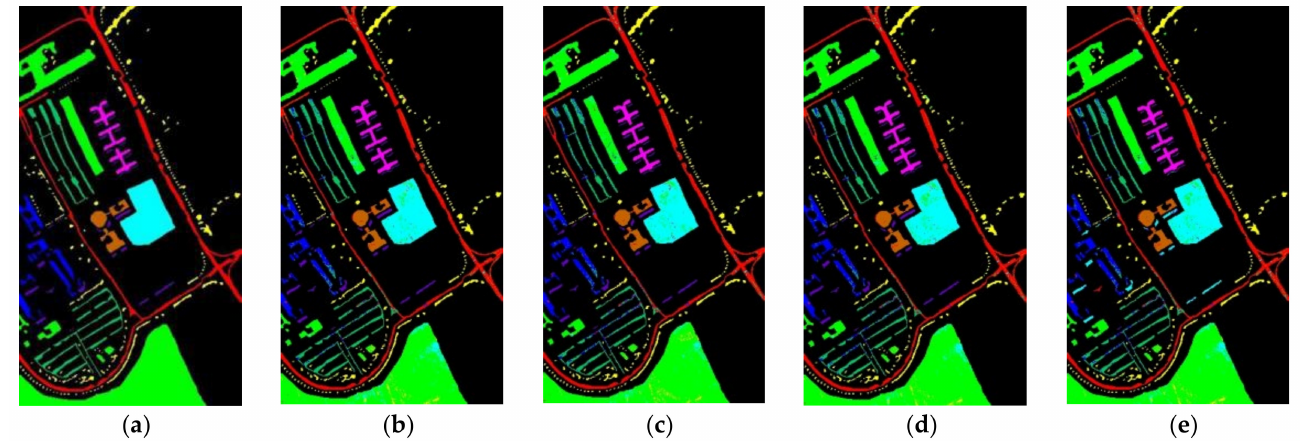
Figure 9. Pavia University hyperspectral image classification result image. ( a ) (ground truth),